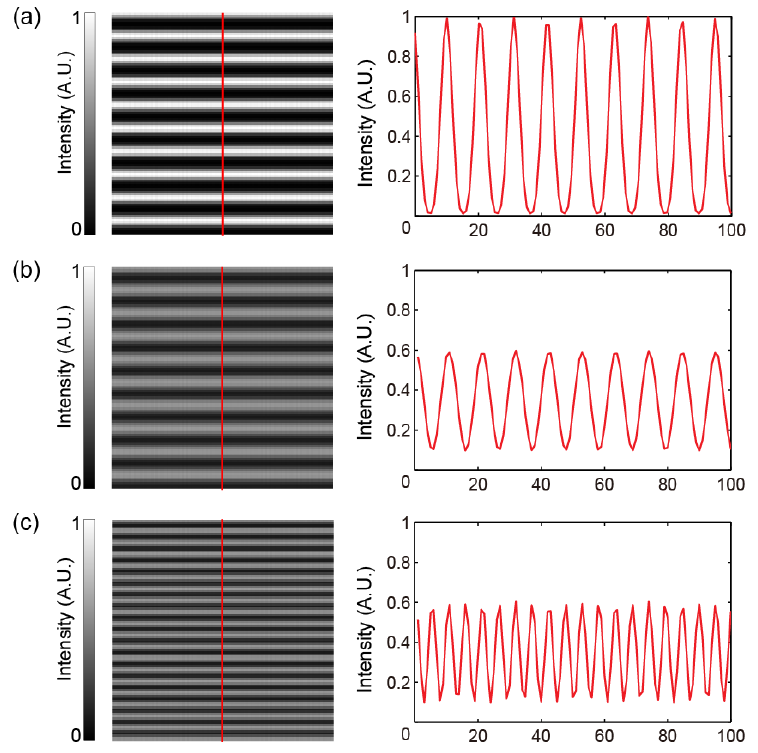
Figure 3. Interference fringe formed by ( a ) symmetrical low diffraction orders, ( b ) unsymmetrical low diffraction orders, and ( c ) unsymmetrical high diffraction orders.